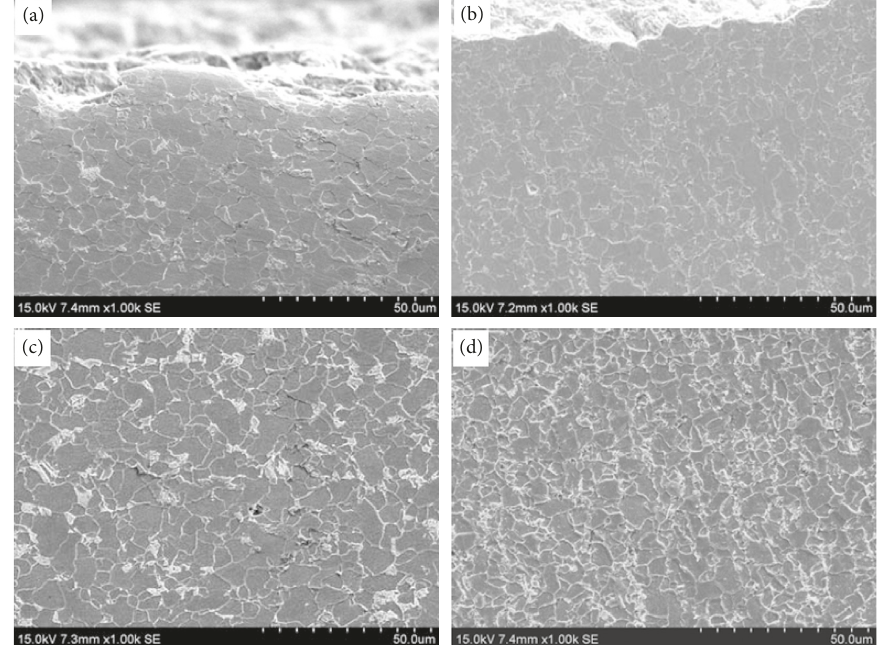
Figure 7: Microstructures of the fracture section of the weld joint specimens (a) with and (b) without surface finishing, and the mi- crostructures of (c) weld junction and (d)